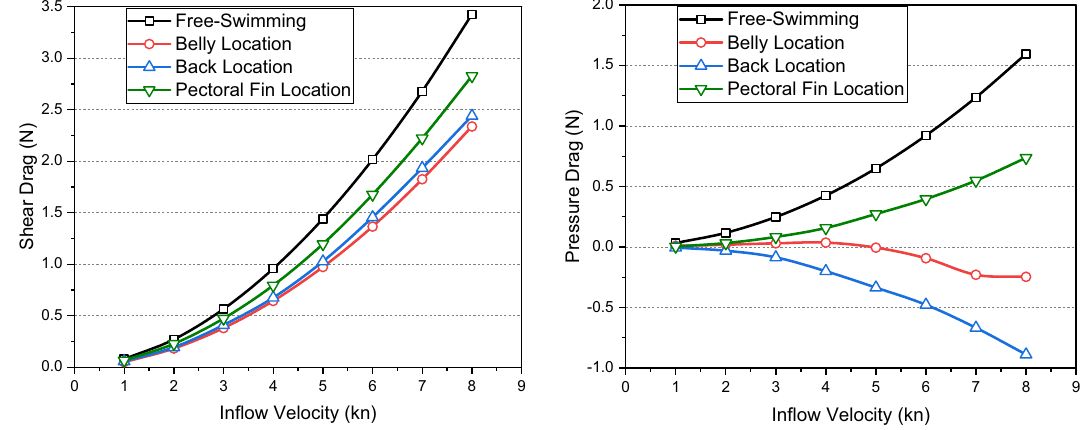
Figure 22. Comparations of the pressure forces and the shear forces for remora in different conditions.